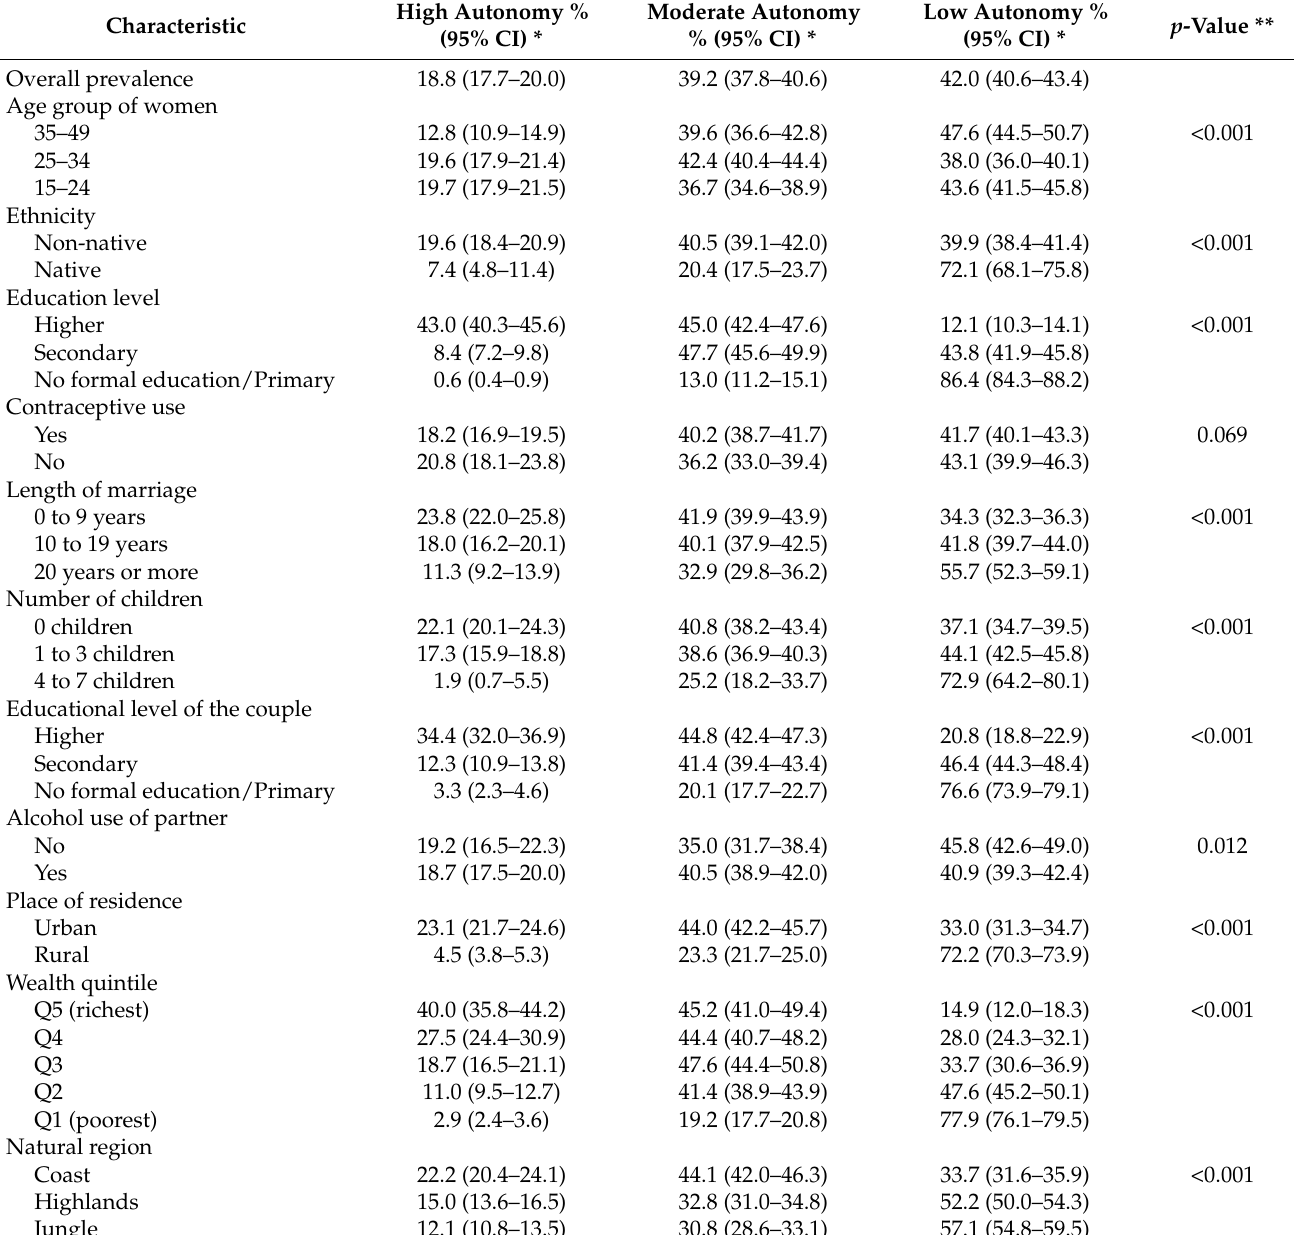
Table 4. Characteristics of Peruvian women aged 15 to 49 years included in the study according to level of